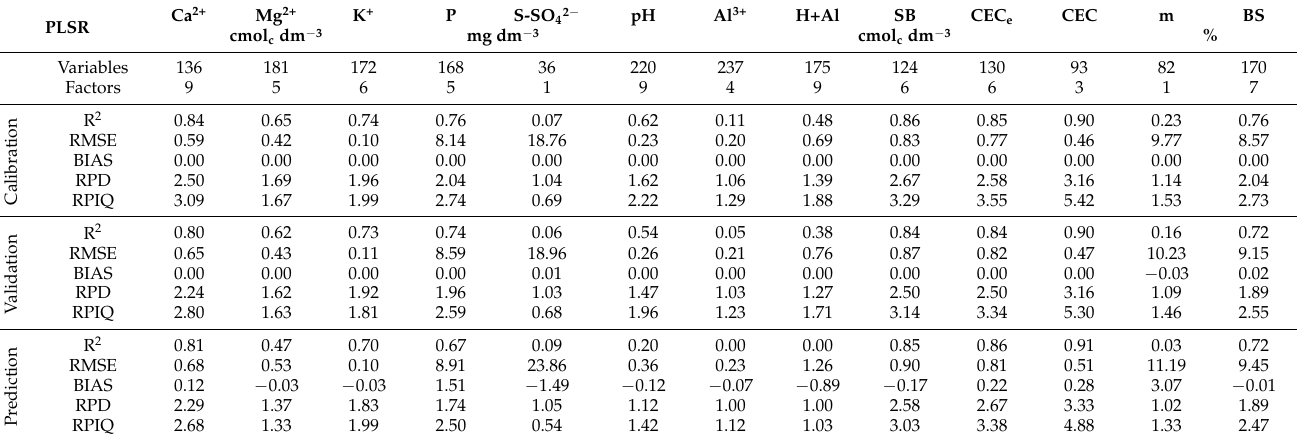
Table 4. Statistical parameters of PLSR models developed from the second soil assessment (with iPLS